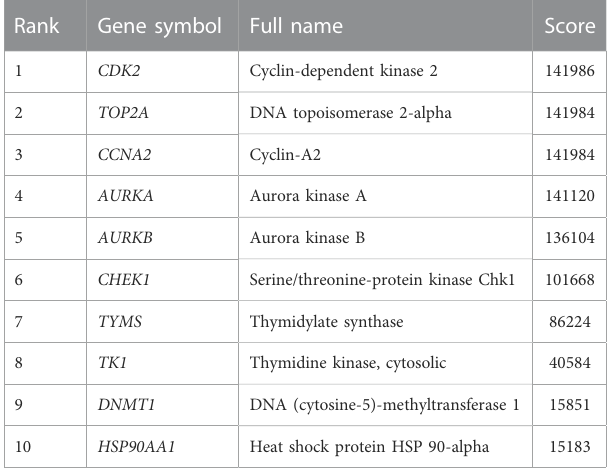
TABLE410Hubgenesidenti fi edusing4differentalgorithmsintheCytohubba plugin. Rank Gene